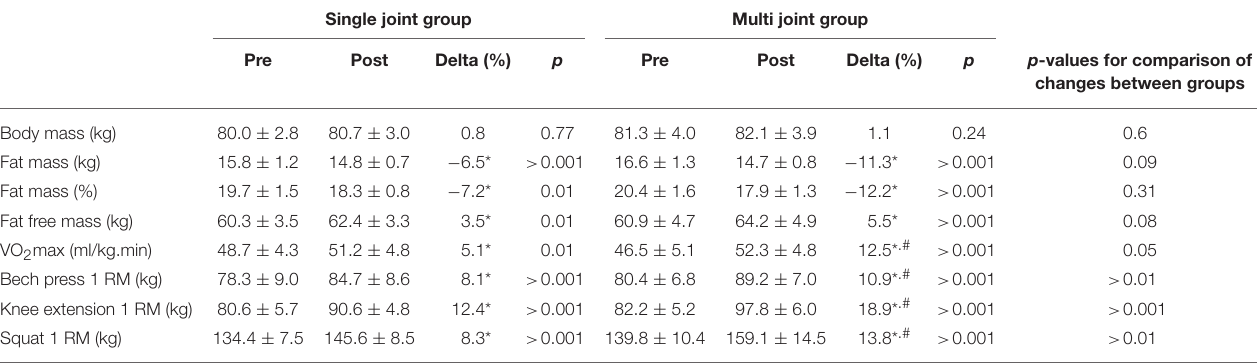
TABLE 2 | Pre and post training values for different variables for single and multi joint groups (mean ± standard deviation). Single joint group Multi joint group Pre Post Delta (%) p Pre Post Delta (%) p p -values for comparison of